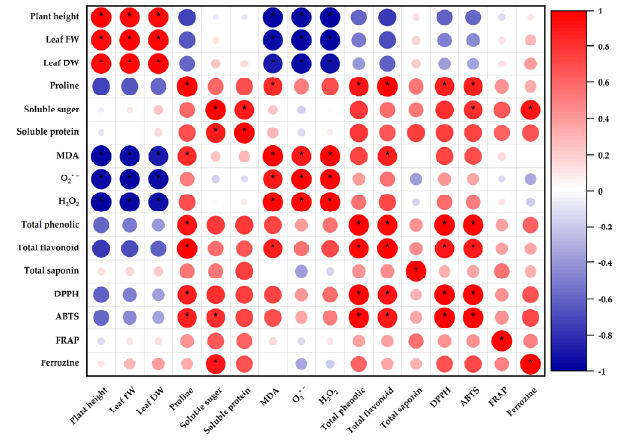
Figure 8. A correlation analysis of physiological, biochemical, and antioxidant activities of H. cannabinus seedlings under salt stress. * Indicates significance at the 5% level, while color depth denotes the correlation coefficient. The strength of the correlation is represented by the size of the circles.